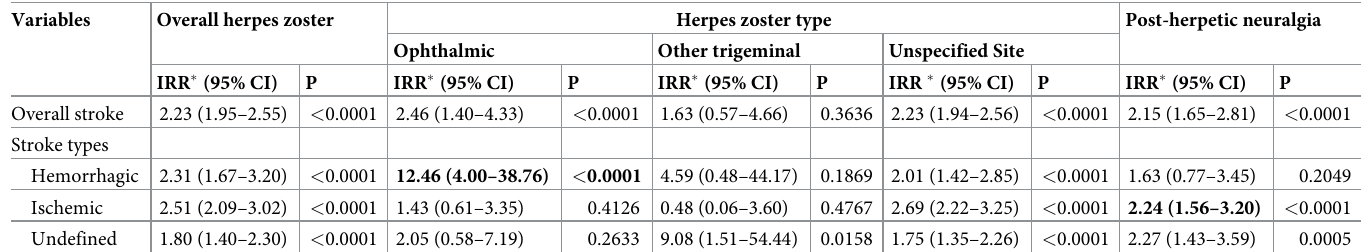
Table 4. Adjusted incidence rate ratios of herpes zoster during risk periods of 12 months following stroke.